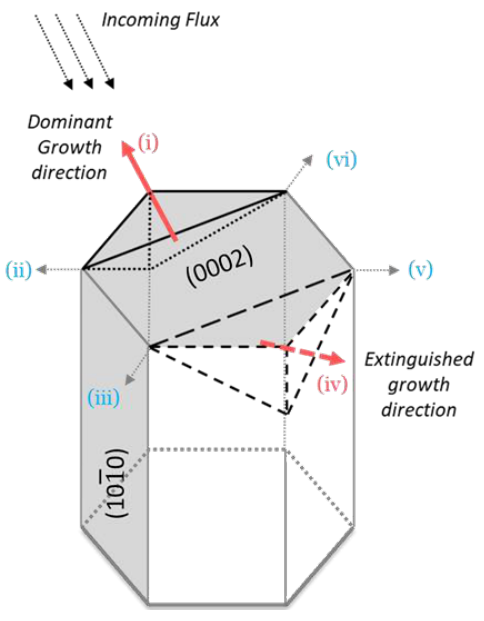
Figure 15. Illustration of dominant (i) and extinguished (ii, iii, iv, v, and vi) growth directions of AlN columns grown using GLAD.